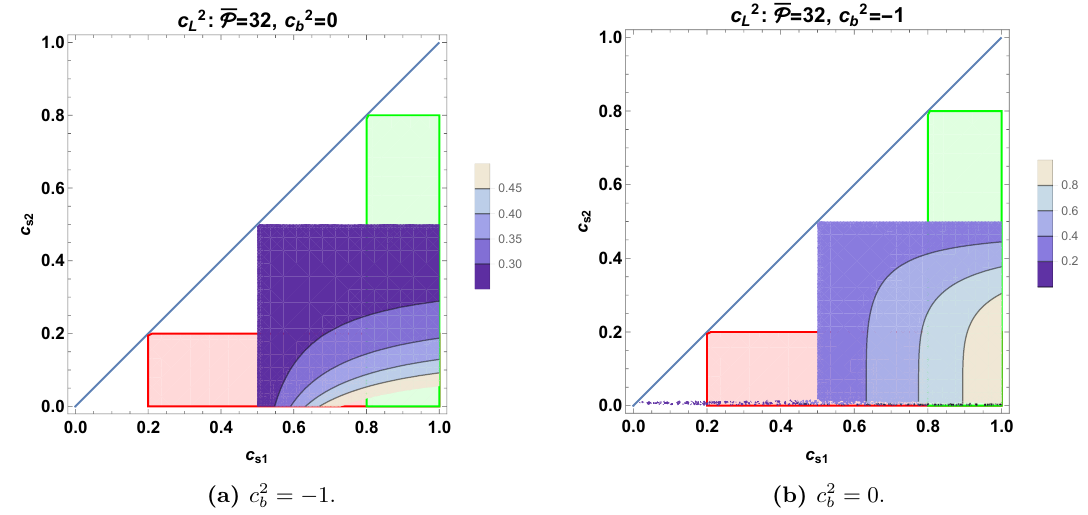
P = 32 which maximizes the